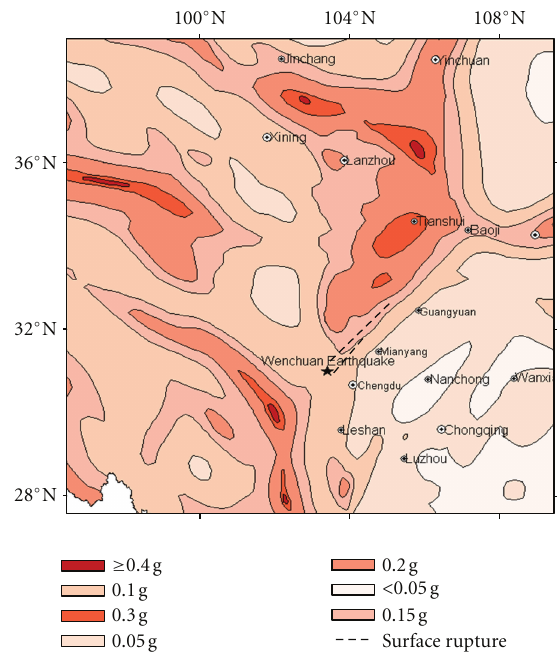
Figure 2: Chinese national design peak ground acceleration for the Wenchuan area